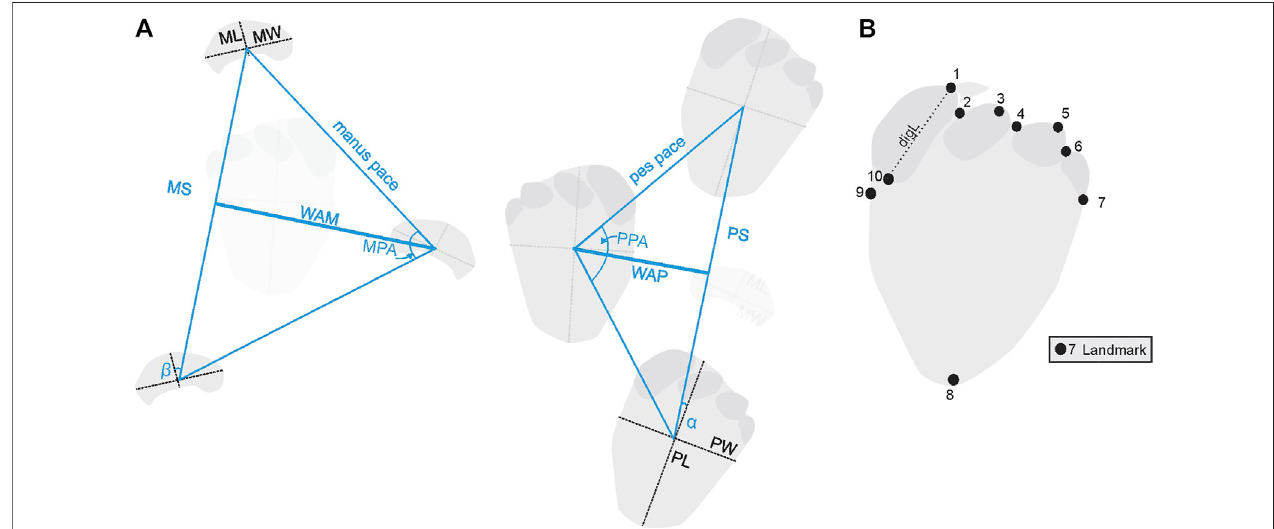
FIGURE 2 | (A) Trackway parameters (adapted from Marty, 2008). (B) Landmark placement on the pes. Acronyms used here and in text: PL: pes length; PW: pes width; α : pes rotation; ML: manus length; MW: manus width; β : manus rotation; PS: pes stride length; PPA: pes pace angulation; WAP: width of the pes angulation pattern; MS: manus stride length; MPA: manus pace angulation; WAM: width of the manus angulation pattern; digL: digit